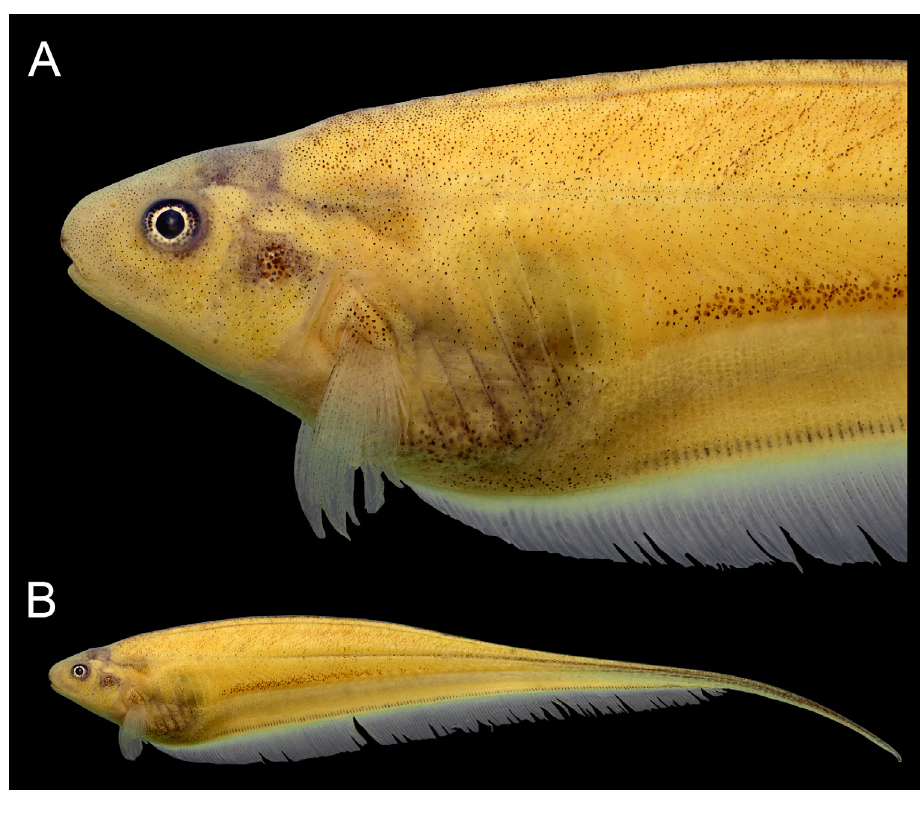
FIGURE 2 | Eigenmannia bumba , MZUSP 125870, holotype, 117.5 mm LEA, rio Santana,